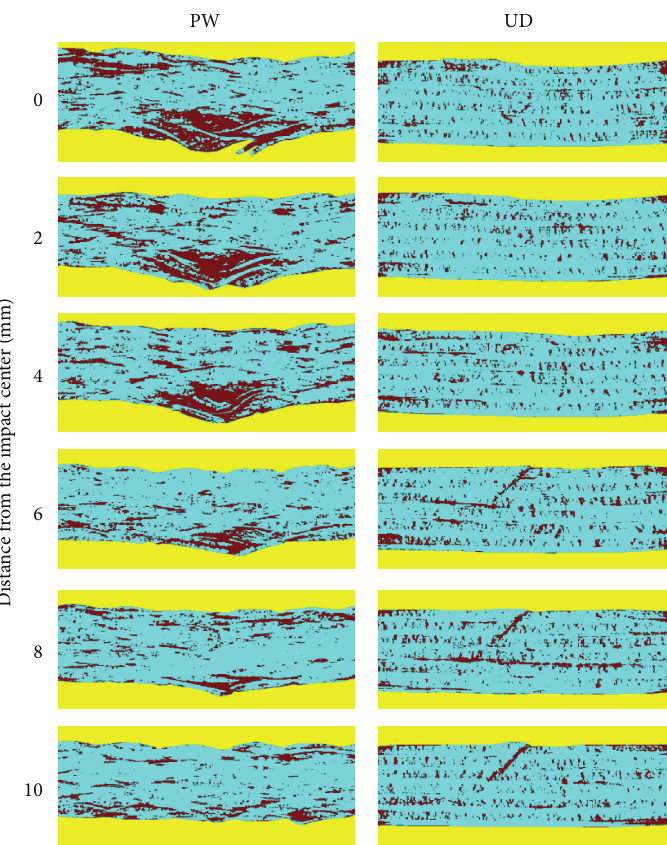
Figure 11: XMT top view histogram of the impacted PW and UD laminates.